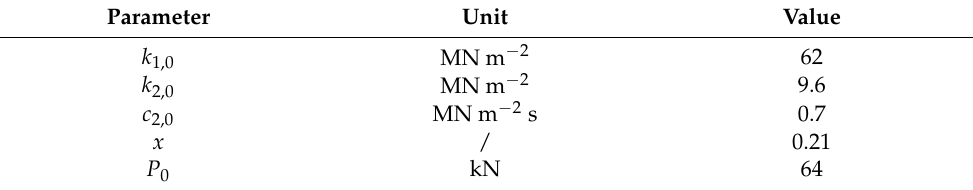
Table 3. Identified parameter values of the non-linear mechanical model of unit length of elastomeric material. Parameter